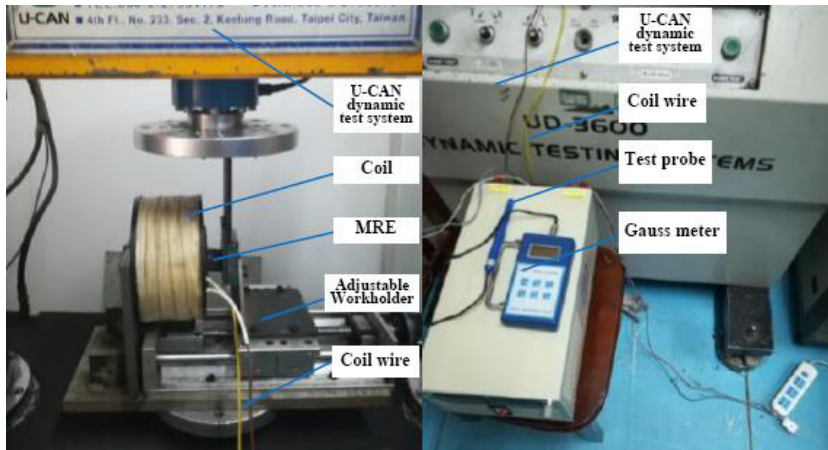
Figure 6. U-CAN dynamic test apparatus.